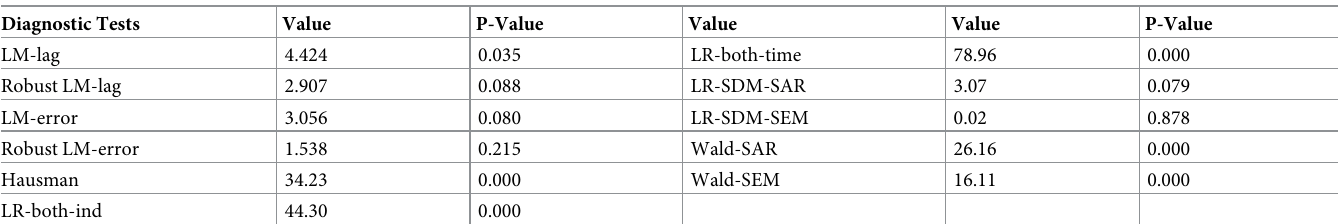
Table 2. Model selection test